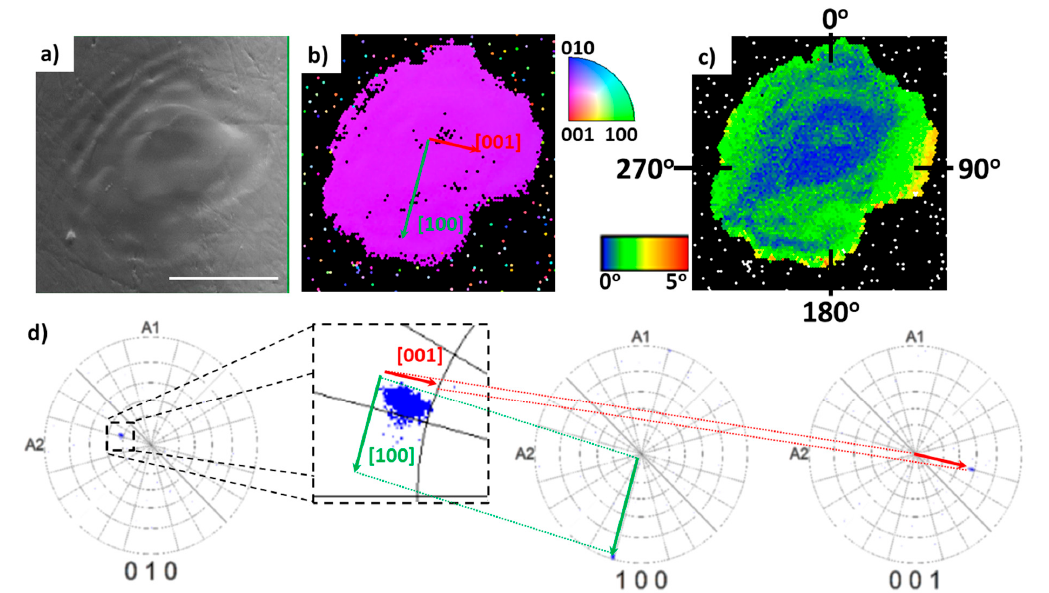
Figure 1. The single crystal dot induced by laser beam with Gaussian intensity distribution on the surface of Sb 2 S 3 glass: ( a ) scanning electron microscope (SEM) image, ( b ) colored inverse pole figure (IPF) map with reference vector normal to sample surface (ND), ( c ) crystal orientation deviation (COD) map with reference to crystal orientation at the center of the dot, the marked numbers indicate positions along the crystal edges in degrees, and ( d ) pole figure (PF) maps in the (010), (100), and (001) crystallographic directions of the crystal dot. The inset represents an enlarged version of the (010) pole figure. The arrows on IPF ( b ) and PF ( d ) maps describe the direction of the lattice cell. The crystal was created by slowly ramping the power density from 0 to 2 mW in 5 s with time exposure 60 s in nitrogen environment. Scale bar corresponds to 4 µ m.